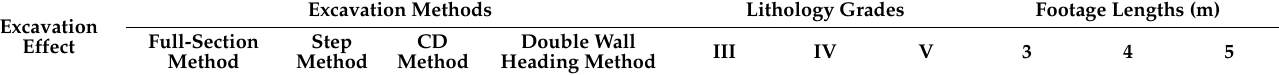
Table 5. Excavation effect in different excavation schemes, surrounding rock grades and footage lengths.